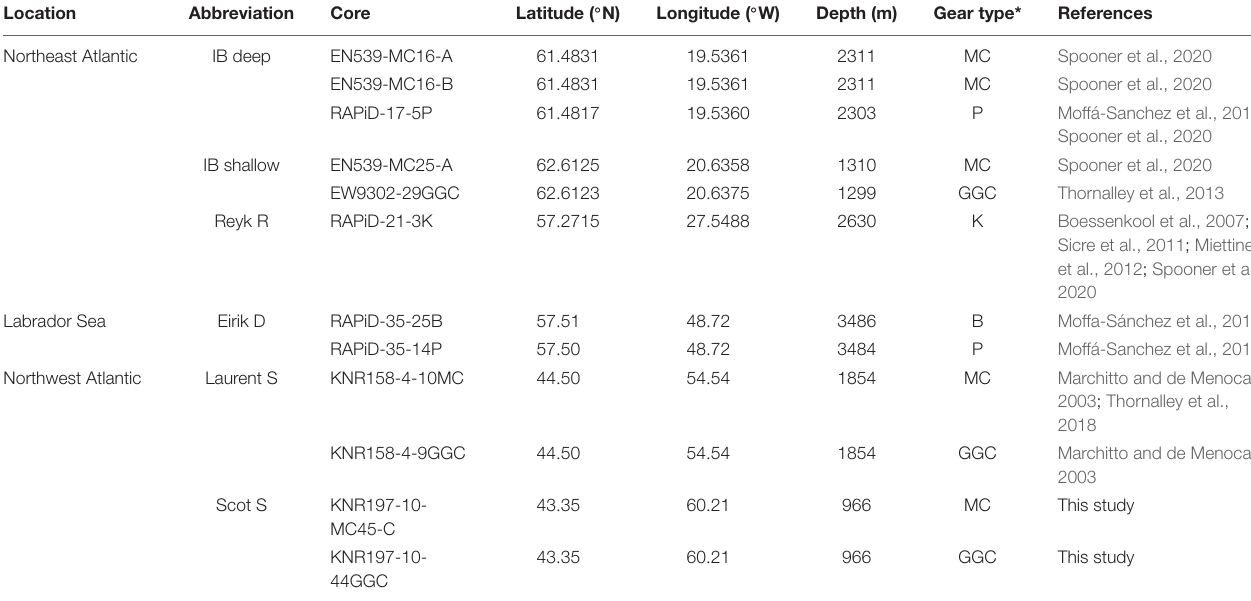
TABLE 1 | Locations and details of sediment cores used in this